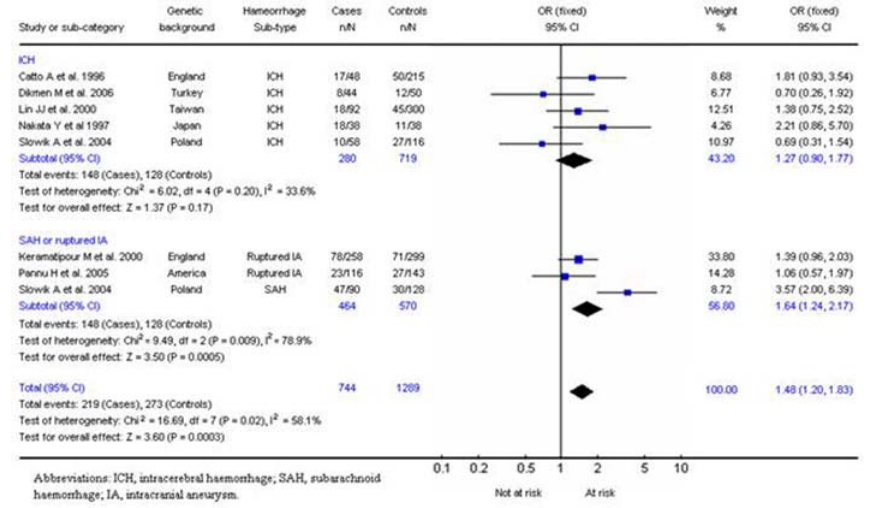
Figure 4. Results for ACE/II gene and haemorrhagic stroke.